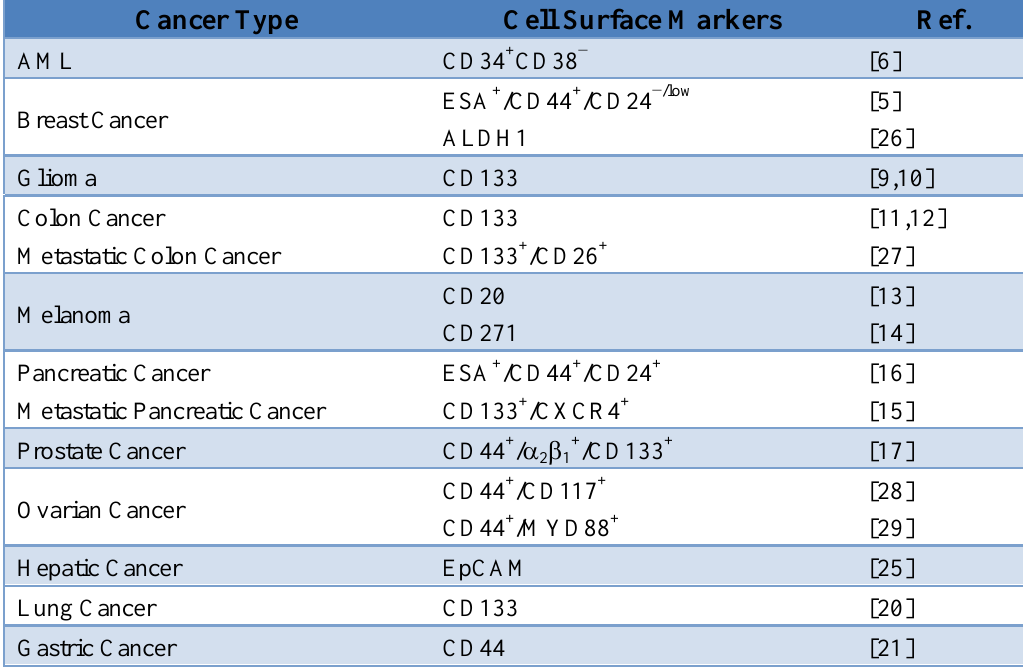
Table1. Representative Cell Surface Markers for Human Cancer Stem Cells